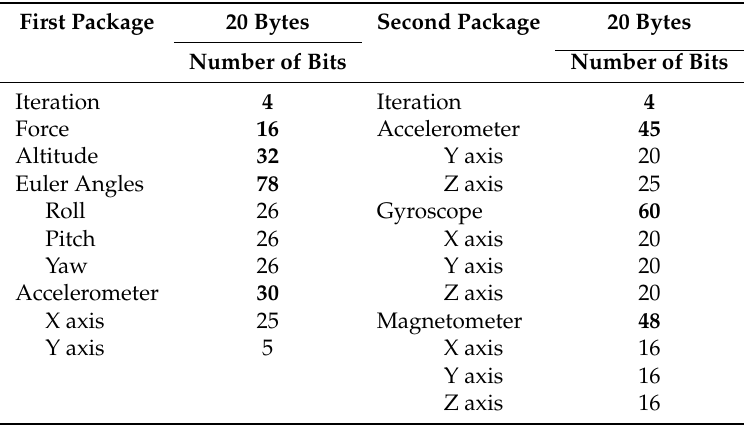
Table 1. BLE package